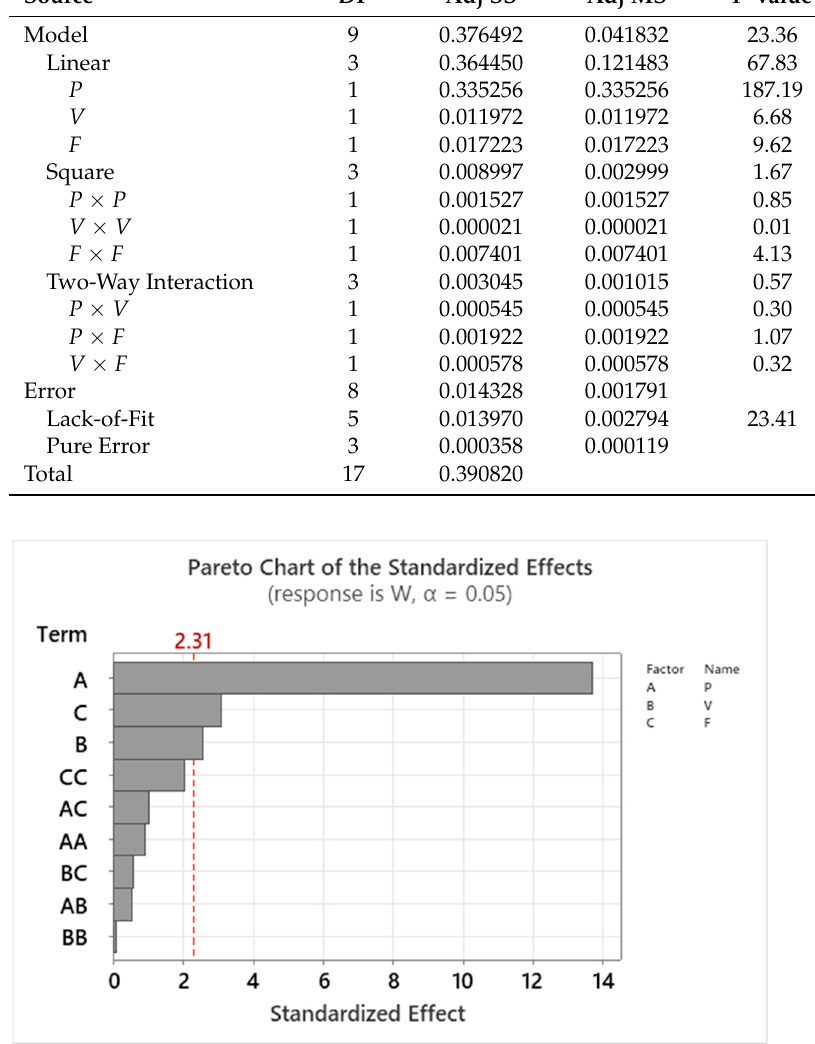
Figure 4. Pareto chart (significance level, α = 0.05) of the standardized effects of process parameters on W .